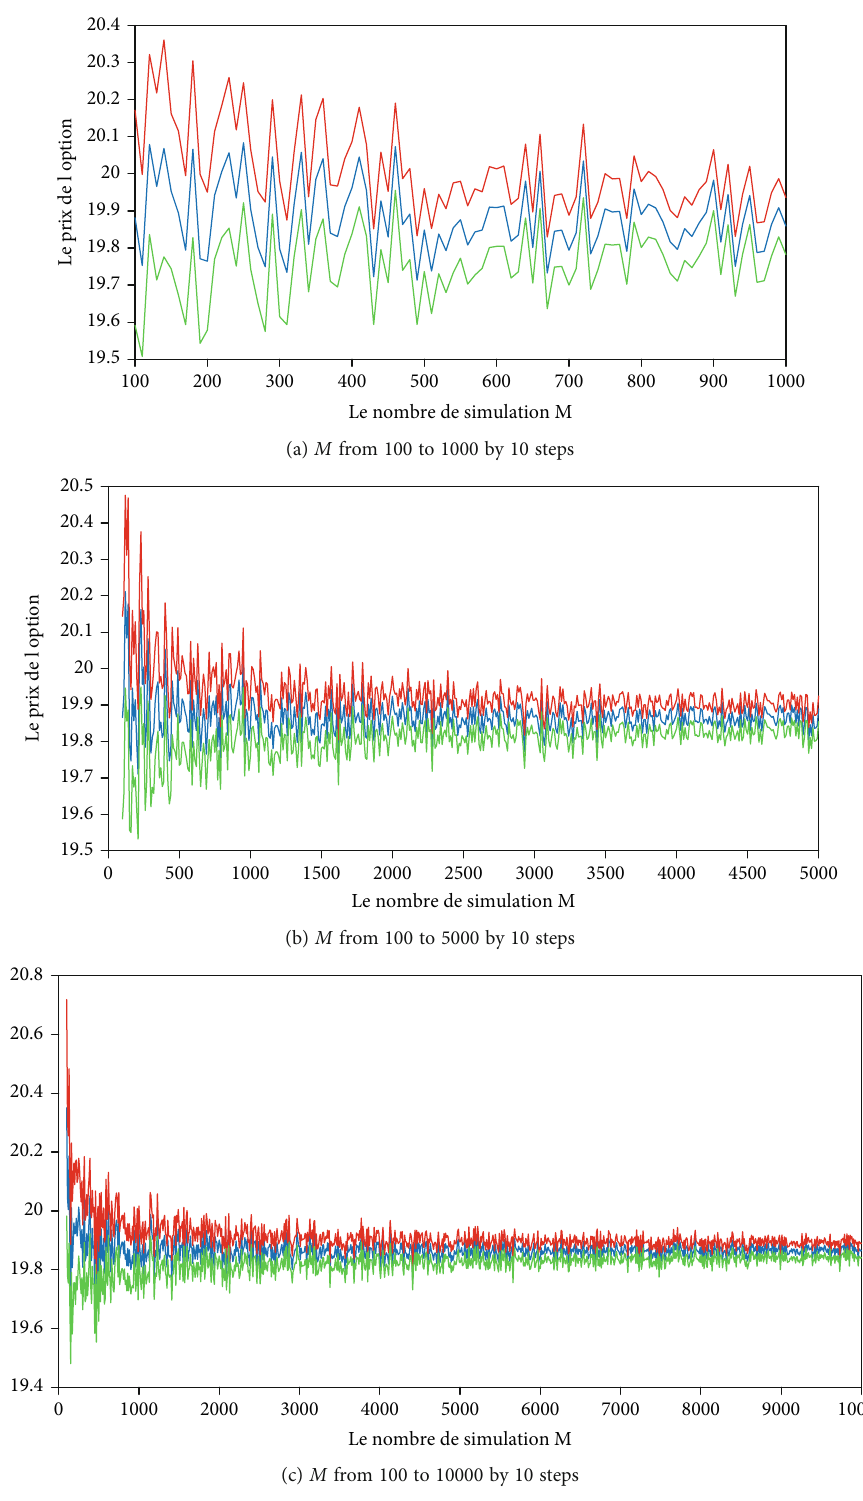
Figure 3: Numerical convergence of Monte Carlo simulation in the least square algorithm under the B&S asset price model. Con fi dence level in order of 95% (the estimated value of the American option in blue, upper bound in red, and lower bound in